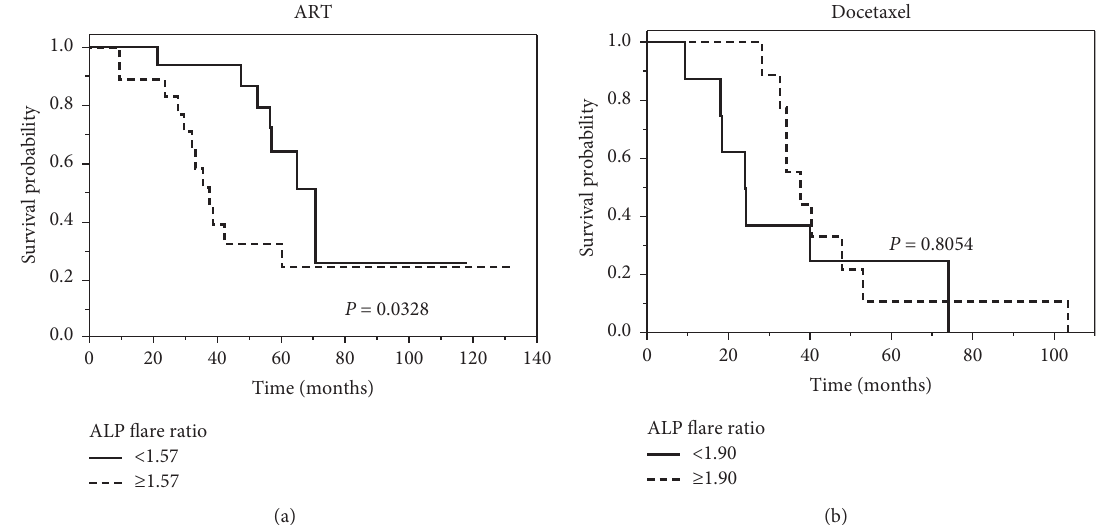
Figure 4: Kaplan–Meier curves showing overall survival (OS) after starting ADT with androgen receptor targeting therapy (ART) (a) or docetaxel (b) as the first-line CRPC treatment, comparing an ALP flare ratio at 1 month less than 1.57 and 1.57 or more (a) and less than 1.90 and 1.90 or more Table 2: Uni- and multivariate analysis of impacts of various parameters on overall survival from diagnosis in patients with metastatic prostate cancer.